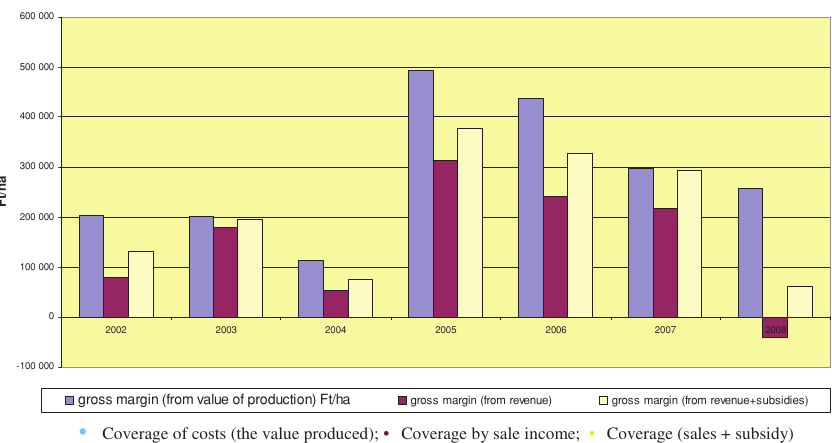
Figure 2. The components of coverage in apple production during the 7 years examined